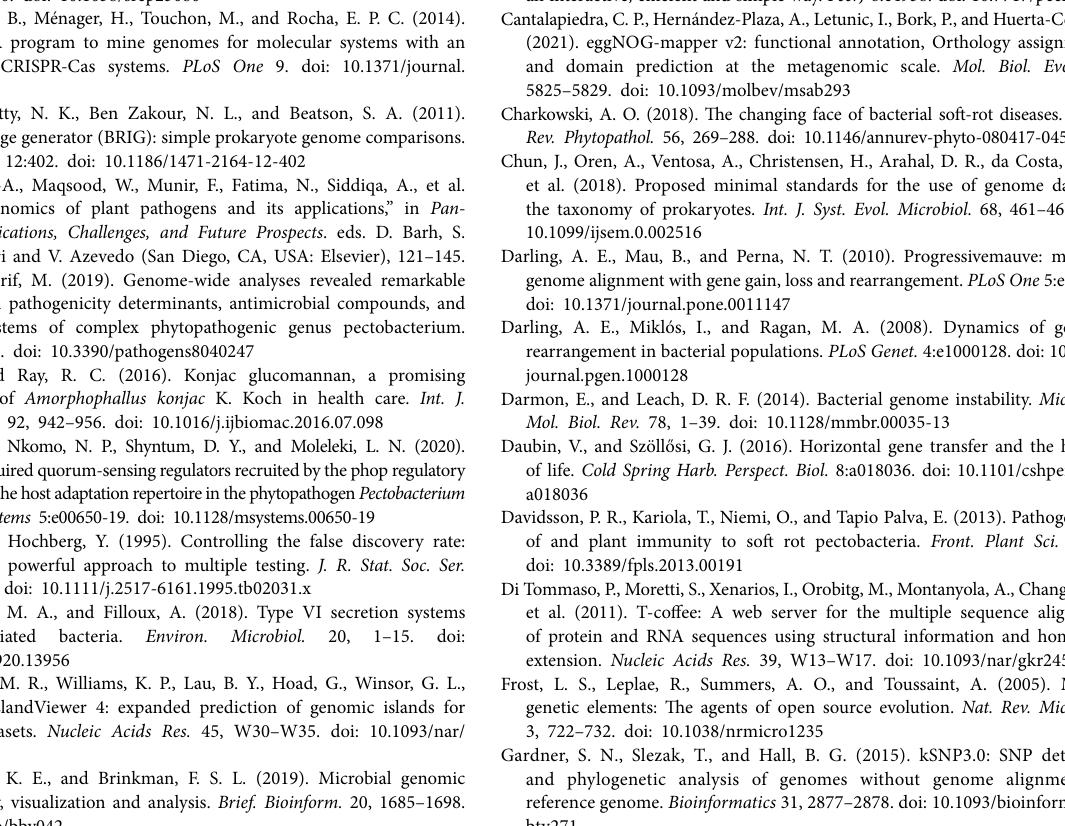
Supplementary Figure 6 | Linear visualization of predicted GIs in 14 P . aroidearum genomes with blocks colored according to the prediction method: